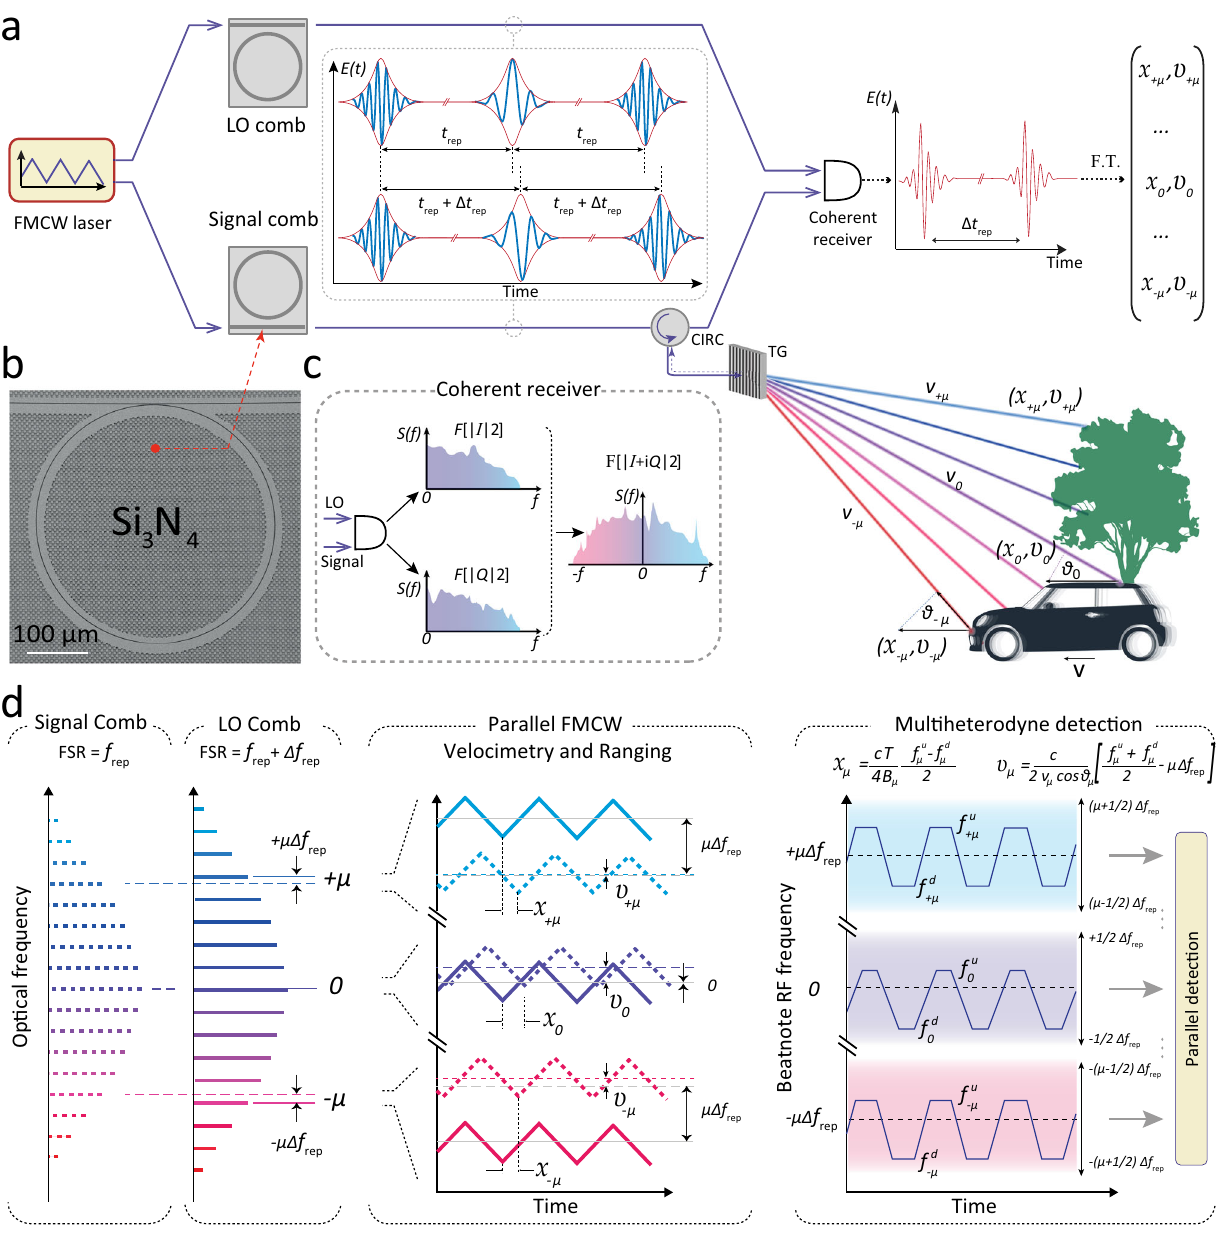
Fig. 1 Multiheterodyne parallelization of coherent laser ranging. a Architecture of the multiheterodyne parallel FMCW LiDAR. A single pump laser with triangular frequency modulation drives two distinct optical microresonators with slightly different radii, which serve as signal and local oscillator (LO) in the experiment. The signal comb is spatially dispersed over the target area using diffractive optics. Each signal comb tooth μ (with an optical frequency ν μ ) represents an independent FMCW ranging channel measuring distance x μ and velocity υ μ . All channels are simultaneously superimposed with the LO comb on a coherent receiver. The interferogram is processed via short-time Fourier transform analysis to retrieve distances x μ and velocities υ μ . b Electron microscope picture of 228.43 μ m Si 3 N 4 microring resonator. c The complex RF spectrum is retrieved by phase diversity detection and Fourier transform. d Principle of multiheterodyne ranging and velocimetry. The Signal and LO combs have repetition rates f rep of 98.90 GHz and 99.39 GHz, respectively. The re fl ected signal comb light is time delayed and frequency shifted due to the Doppler effect. Beat notes of consecutive comb tooth pairs are spaced 490 MHz in the RF spectrum. Triangular frequency modulation maps the distance of target objects to two RF beat notes, f d μ and f u μ , spaced around the center frequency of the multiheterodyne channel μ ⋅ f rep offset by the Doppler shift caused by the relative velocity of LiDAR transmitter and target. First, we obtained a heterodyne beatnote by superimposing the modulation pattern. The delayed homodyne beat note spectrum frequency combs individually with an external-cavity diode laser for the same channels is depicted in Fig. 2e where the delay line onto two balanced photoreceivers (BPD). The resulting signals distance corresponds to the frequency splitting. were analyzed by short-time Fourier transform. Figure 2d shows The maximum number of LiDAR channels is limited by the the laser frequency of the two simultaneously chirped local optical ampli fi cation and coherent receiver bandwidths B pd . The oscillator and signal microcomb for channels μ = ±3, ±11, latter limitation reads as μ Δ f rep < B pd and can be overcome by reducing the repetition rate difference Δ f rep with the trade-off of a highlighting the similarity and relative spacing of the frequency NATURE COMMUNICATIONS| (2022) 13:3280